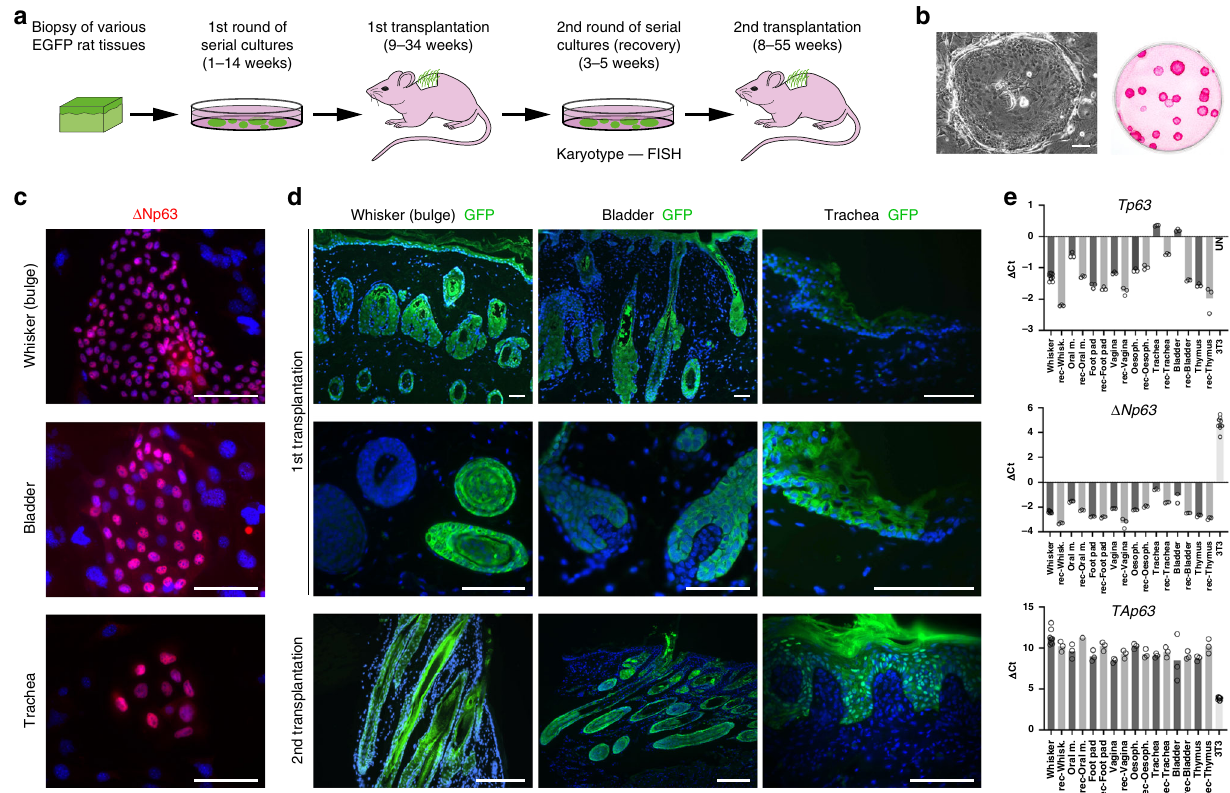
Fig. 1 Cultured Tp63-expressing epithelial stem cells have hairy skin competence. a Schematic representation of the experimental strategy. Various epithelial cells were obtained from EGFP rats, cultured and serially transplanted into the skin of newborn wild type mice. A typical experiment, from the initial biopsy to the end of the 2nd transplantation, usually ran for more than a year. b Typical appearance of colonies initiated by esophageal epithelial cells (10 independent experiments). Left: phase contrast appearance of a 7 days old progressively growing colony; bar: 100 μ m. Right: appearance of 10 days old Rhodamine B stained colonies (red). c Immunostaining showing that clonogenic epithelial cells cultured from whisker, bladder and trachea expressed Δ Np63 (red nuclear staining). Nuclei (blue) were counterstained with Hoechst 33342. d Serial transplantation of Tp63-expressing epithelial stem cells from whisker, bladder, and trachea into the skin of newborn wild type mice; 34 mice were transplanted in the fi rst round of transplantation out of which 21 displayed a long-term EGFP transplant; 23 mice were transplanted in the second round of transplantation out of which 12 displayed a long-term EGFP transplant. Representative microphotographs showing that transplanted EGFP cells from whisker and bladder formed epidermis, hair follicles, and sebaceous glands whereas tracheal cells only formed an epidermis-like epithelium. EGFP expression in the transplanted cells was revealed by immunohistochemistry. First transplantation: upper and middle panels; Upper panel: whisker: 236 days old transplant; bladder (dome): 238 days old transplant; trachea: 122 days old transplant. Middle panel: high magni fi cation showing that the EGFP cells contributed to the differentiated layers of epidermis and hair follicles. Whisker: 100 days old transplant; bladder (dome and trigone): 238 days old transplants; trachea: 122 days old transplant. Second transplantation: lower panel; Whisker: 117 days old transplant; bladder (trigone): day 84 transplant; trachea: 100 days old transplant. Nuclei (blue) were counterstained with Hoechst 33342; bars: 100 μ m. e Dot plot showing the expression of Tp63, Δ Np63, and TAp63 isoforms determined by qPCR analysis before and after the 1st round of transplantation. Δ Ct results were normalized against housekeeping genes ( TBP , SDHA, and Tubb ). Mean of 3 – 9 technical replicates with individual data represented by empty